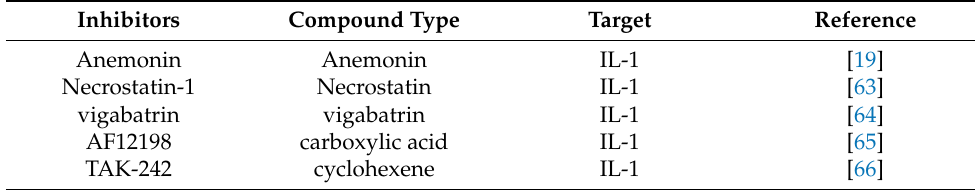
Table 3. Small molecule inhibitors targeting IL-1 for OA.